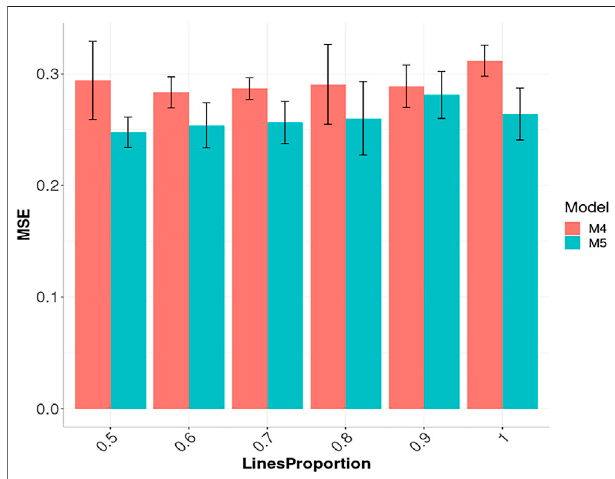
FIGURE 6 | Prediction performance across environments (Global) in Maize data in terms of Mean Square Error (MSE) of models M4 and M5 using the sparse Arc_cosine_1 kernel with six proportions of compression levels: 0.5,0.4,0.3,0.2,0.1and0,whichcorrespondtousingonlythefollowing proportions: 0.5, 0.6, 0.7, 0.8, 0.9 and 1 of the original lines (LinesProportion) for computing the kernels. M4 denotes the random forest model and M5 denotes the Bayesian regression model. The complement of level of compression level is equal to the proportion of lines used to compute the sparse kernel, that is, level of compression = 1 minus proportion of lines used to compute the sparse